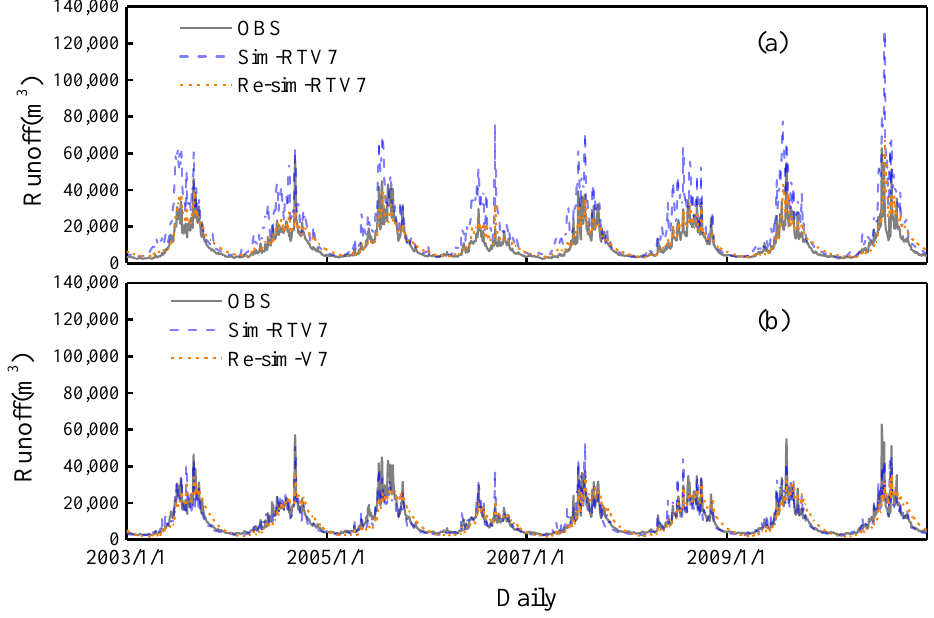
Figure 9. Comparison of gauged and simulated runoff based on the TMPA 3B42RTV7 and TMPA 3B42V7 precipitation products by using the VIC hydrological model in the upper Yangtze reaches from 2003 to 2010 at daily scale. ( a ) Simulated runoff using the parameters obtained from the gauged precipitation and TMPA 3B42RTV7; ( b ) simulated runoff using the parameters obtained from the gauged precipitation and TMPA 3B42V7. Table 4. The statistical summary of the simulated runo ff driven by TMPA 3B42TRV7 / V7 using di ff